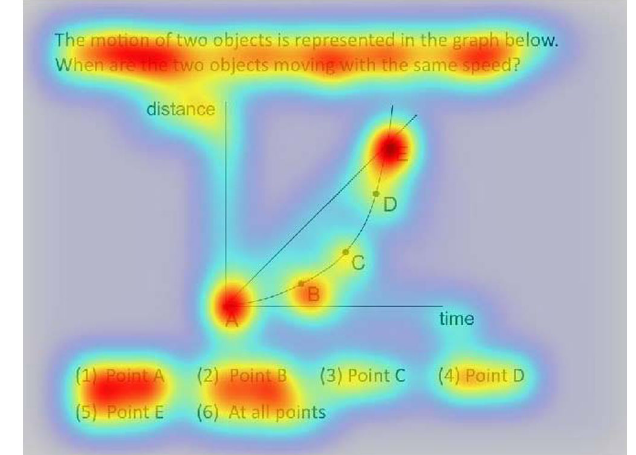
FIG. 4 (color online). Itti, Niebur, and Koch saliency map for problem 7. The perceptually salient AOI partially overlapped with the novicelike AOI, which was at the point where the two lines